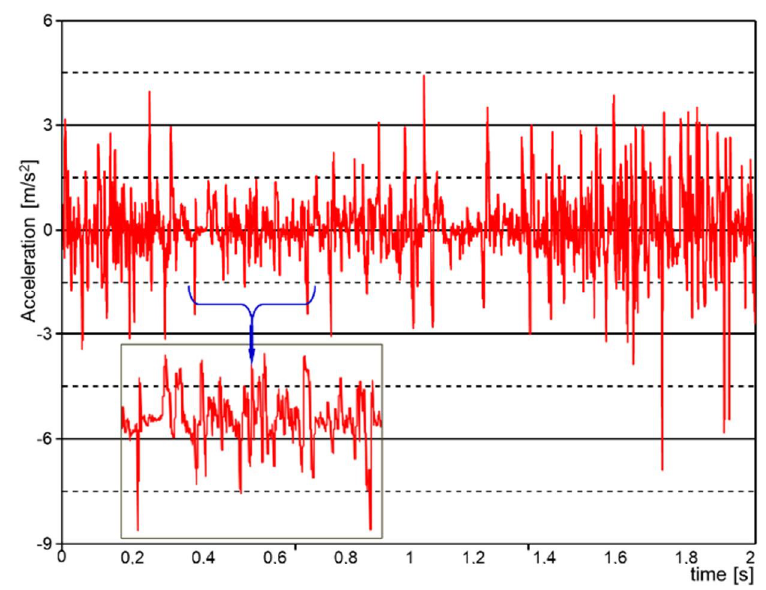
Figure 19. The evolution of the longitudinal acceleration while braking on a slope, determined with the help of a GPS sensor system.